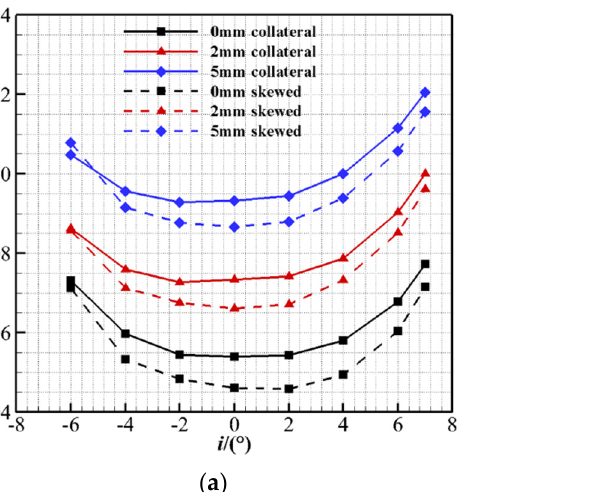
Figure 22. The variation of the total pressure loss coefficient and the static pressure rise coefficient with the incidence angle under different IBL conditions: ( a ) Total pressure loss coefficient; ( b ) Static pressure rise coefficient.